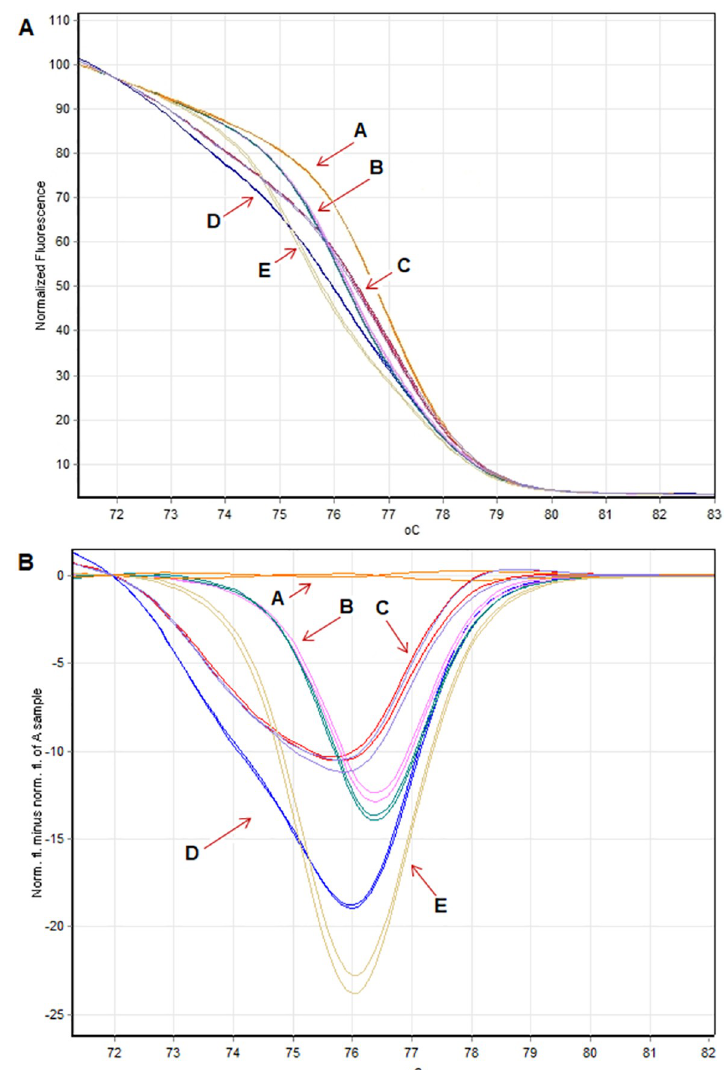
Fig 3. Results of qPCR-HRM analysis. A. The normalized HRM profile of five identified genotypes. B. The difference graph (sample A genotype 3/3 was selected as reference). A. (TTTAT) 3 /(TTTAT) 3 homozygote. B. (TTTAT) 4 /(TTTAT) 4 homozygote. C. (TTTAT) 3 /(TTTAT) 4 heterozygote. D. (TTTAT) 4 /(TTTAT) 5 heterozygote. E. (TTTAT) 5 /(TTTAT) 5